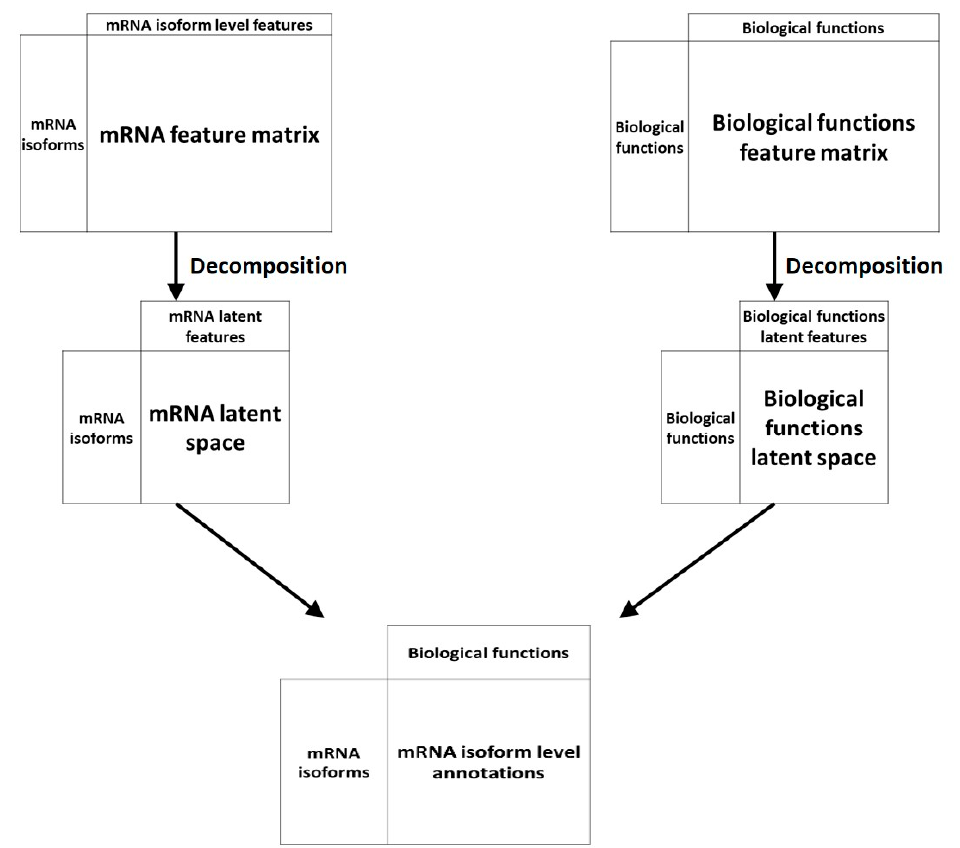
Figure 4. An overview of recommendation system approaches for mRNA isoform function prediction. In recommendation system-based approaches, the mRNA isoform level features and the features at the biological functions like GO are projected to a latent space which are then associated by a decomposition unit to produce the final mRNA isoform level function recommendations.